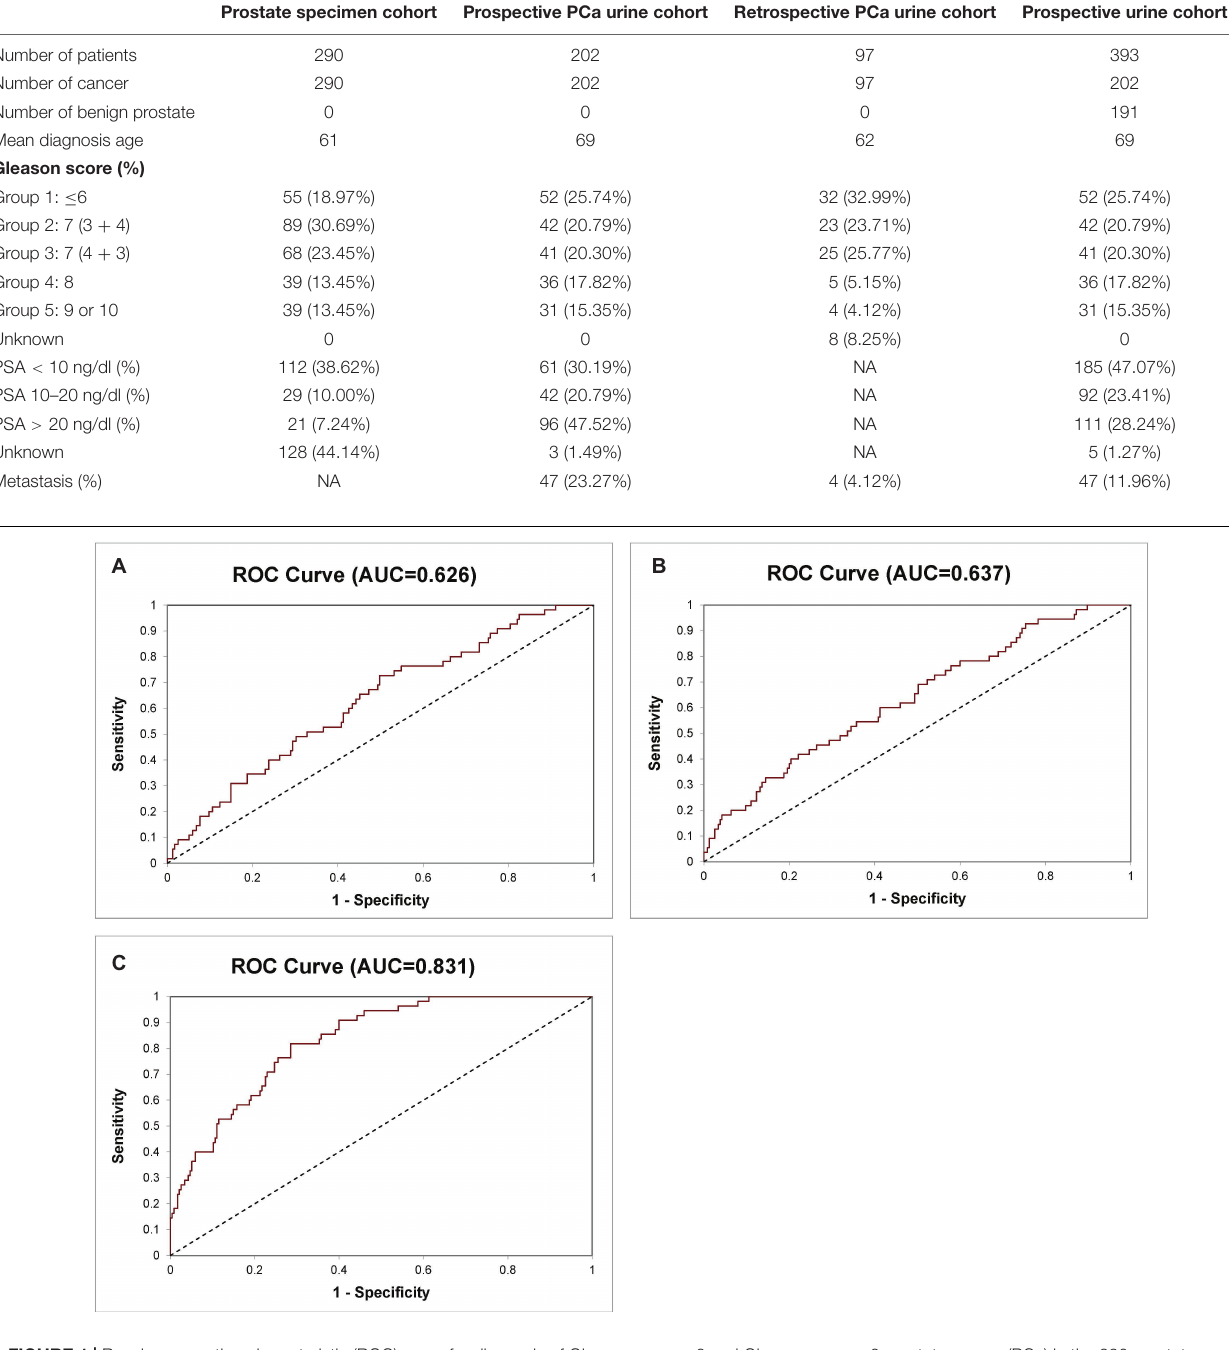
TABLE 1 | Characteristics of